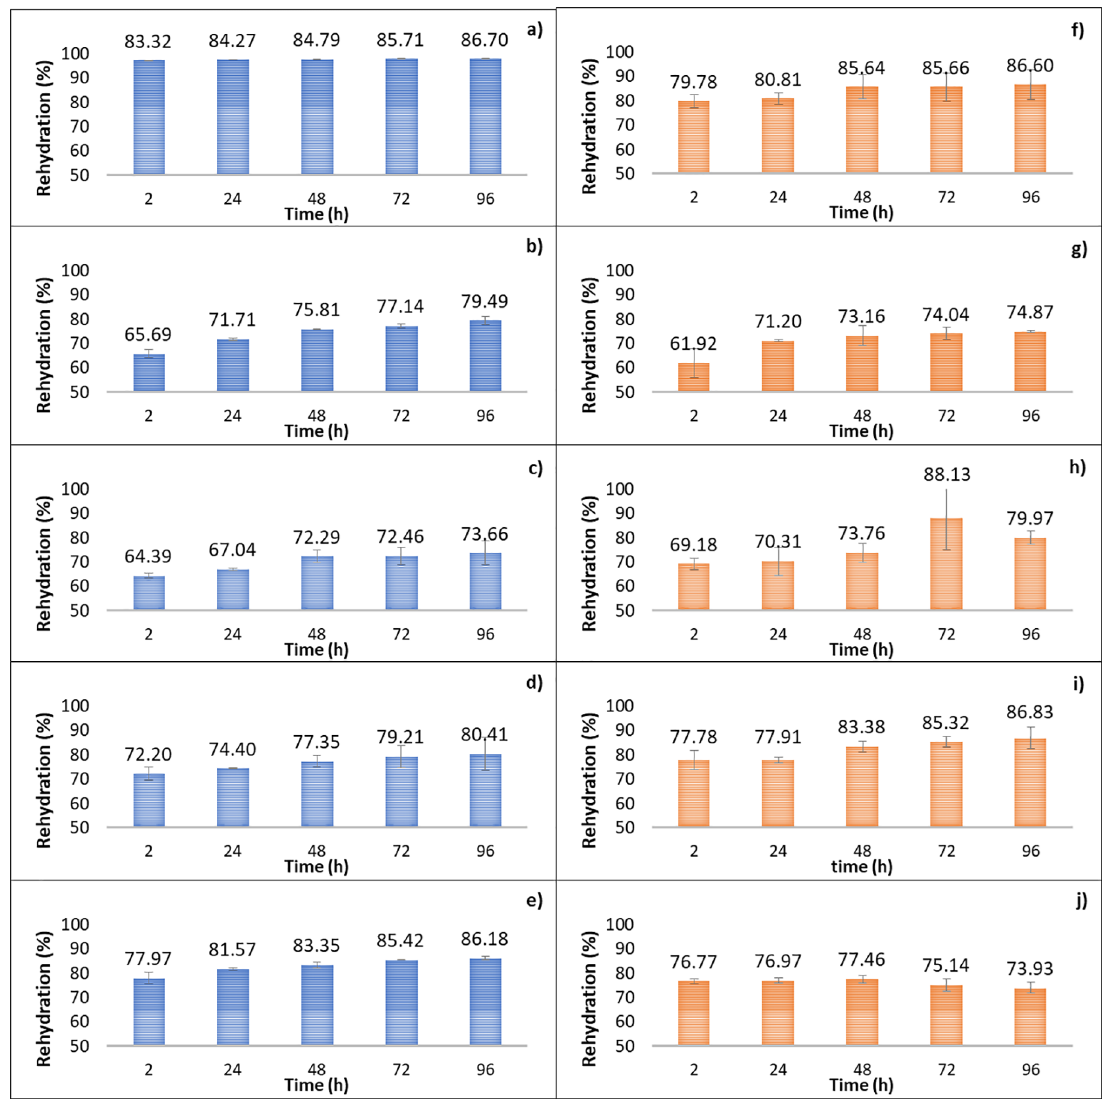
Figure 5. Rehydration capacity (%) of functionalized BC membranes over time. a) Ag40A, b) Ag20CN2.2A, c) Ag40CN2.2A, d) Ag20CN1.1A, e) Ag40CN1.1A, f) Ag40O, g) Ag20CN2.2O, h) Ag40CN2.2O, i) Ag20CN1.1O, j) Ag40CN1.1O).